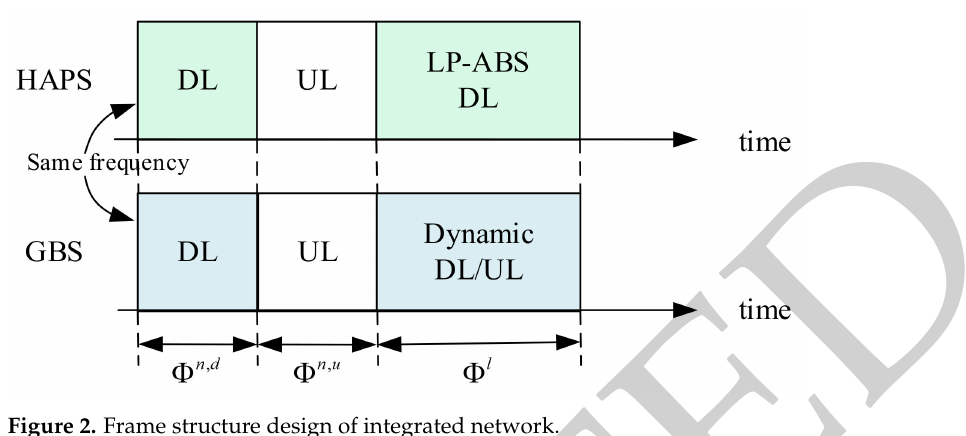
Figure 2. Frame structure design of integrated